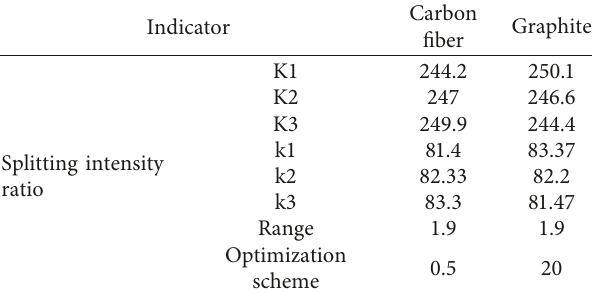
Table 14: Range analysis of freeze-thaw splitting